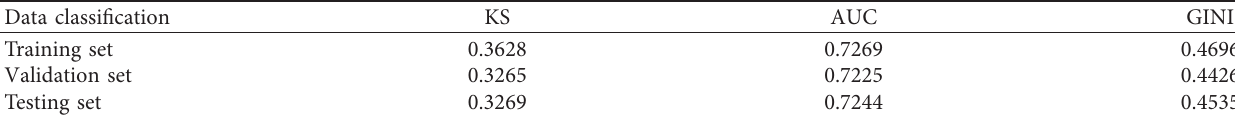
Table 8: Result evaluation of credit scoring